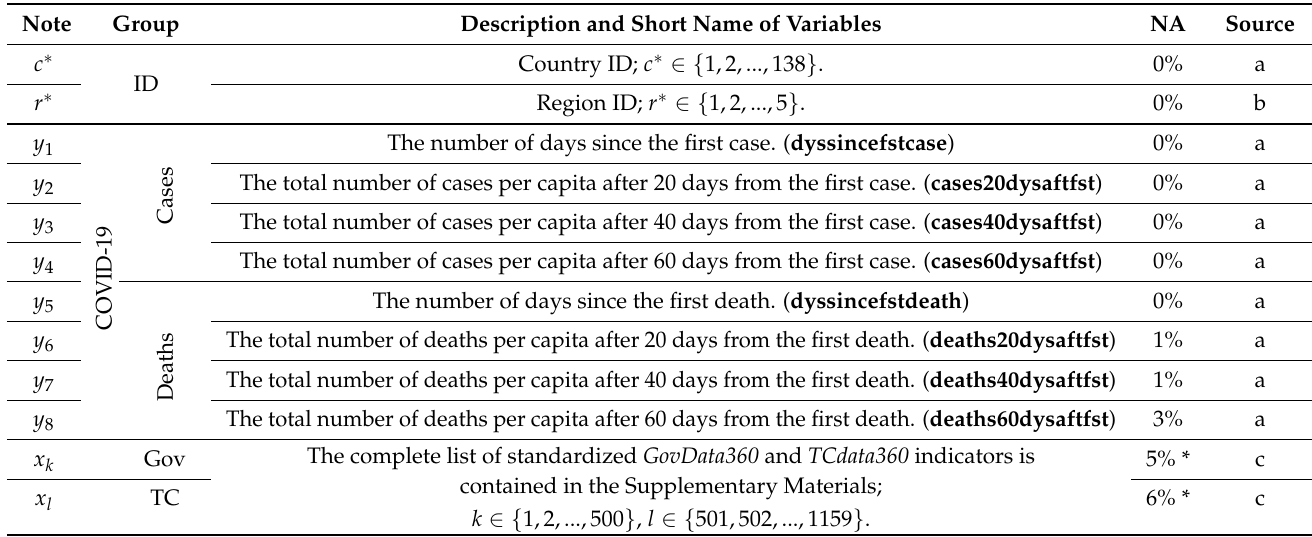
Table 1. Variable